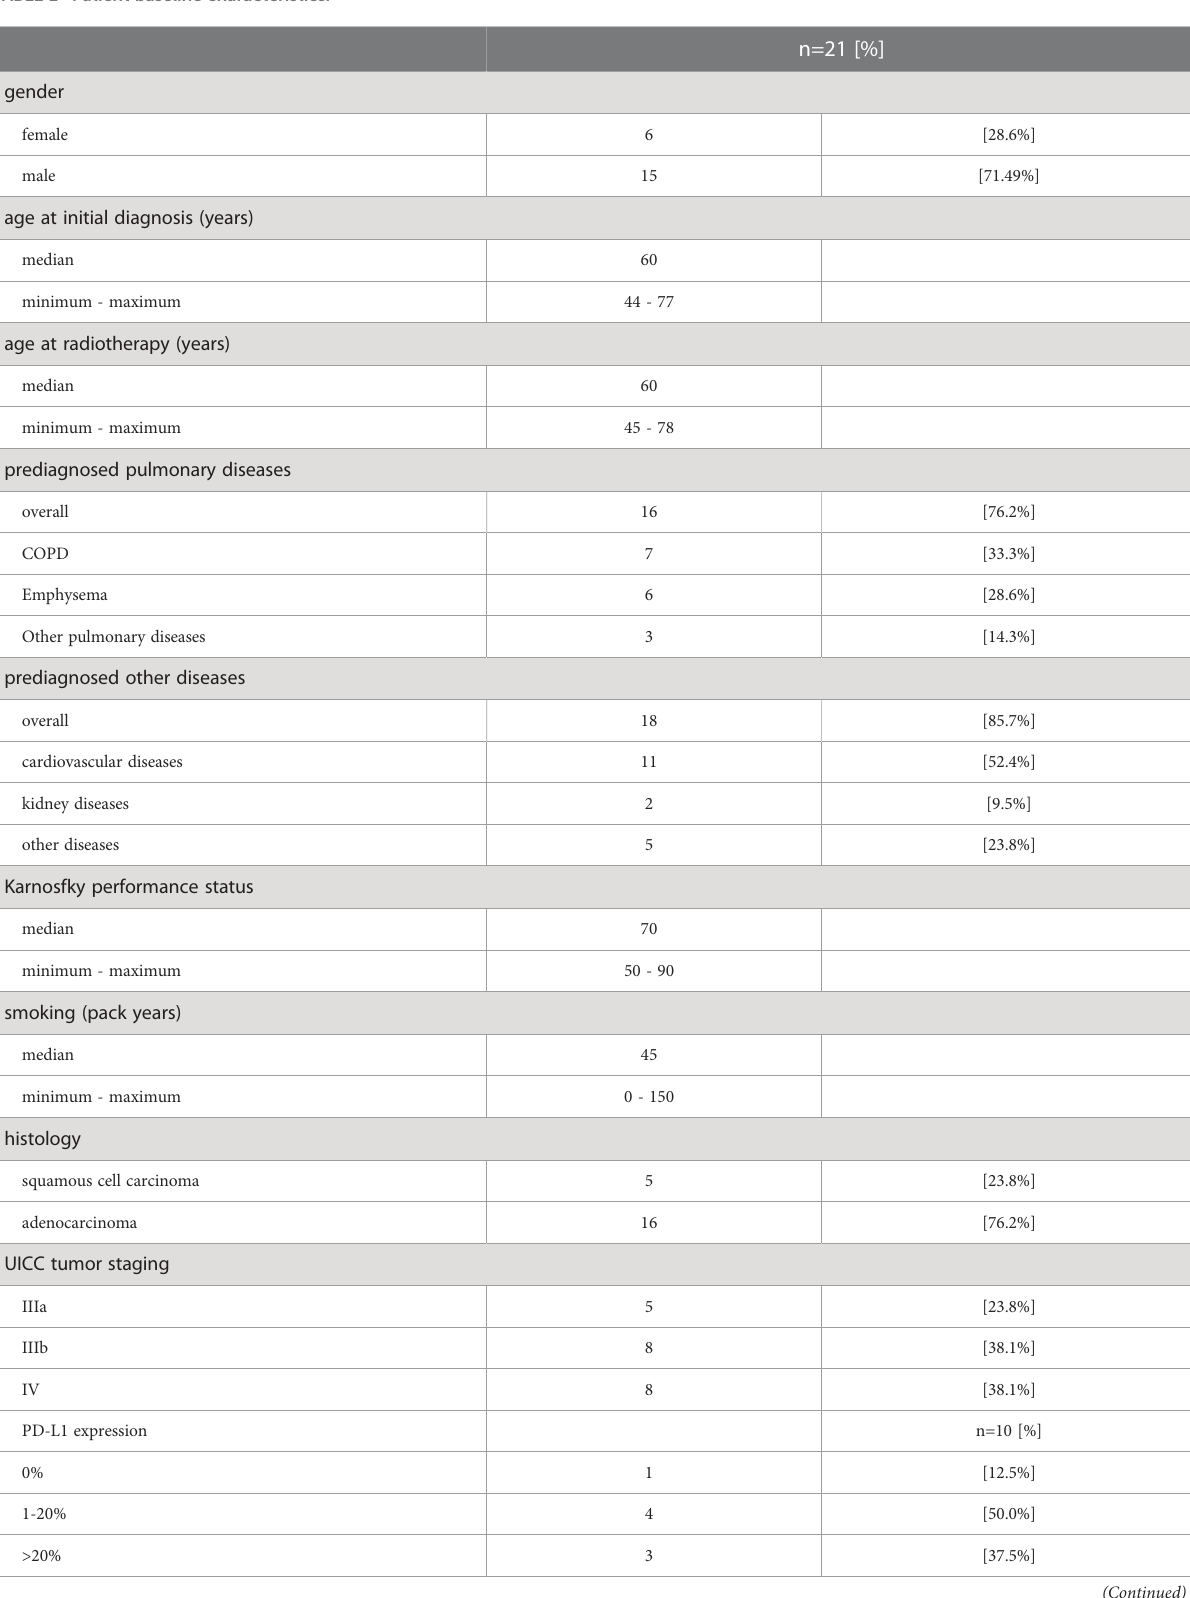
TABLE 1 Patient baseline